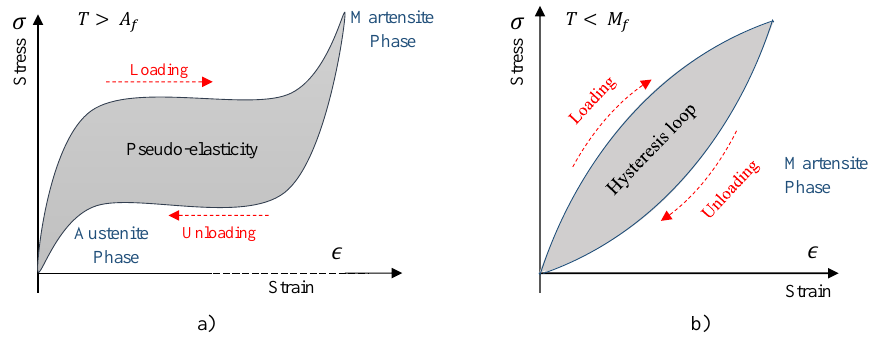
Figure 2. ( a ) Schematic of a pseudo-elastic behaviour. ( b ) Schematic of stress strain nonlinearity at low strain ranges (less than 0.4%) in the martensitic state of a SMA